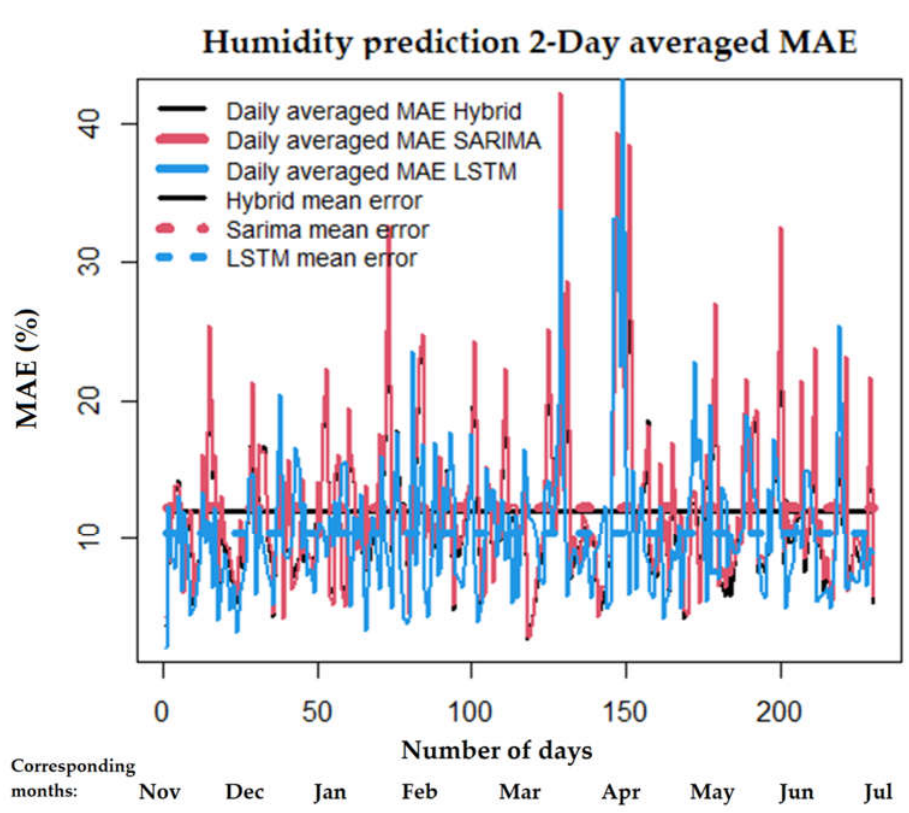
Figure 9. Comparison of SARIMA, LSTM and hybrid using daily averaged MAE with real data for 2-day prediction horizon on humidity prediction for 230 days of the test set. With dashed lines the average error of all the dataset is shown. Units of MAE are in percentage (%) in this humidity ex- ample.